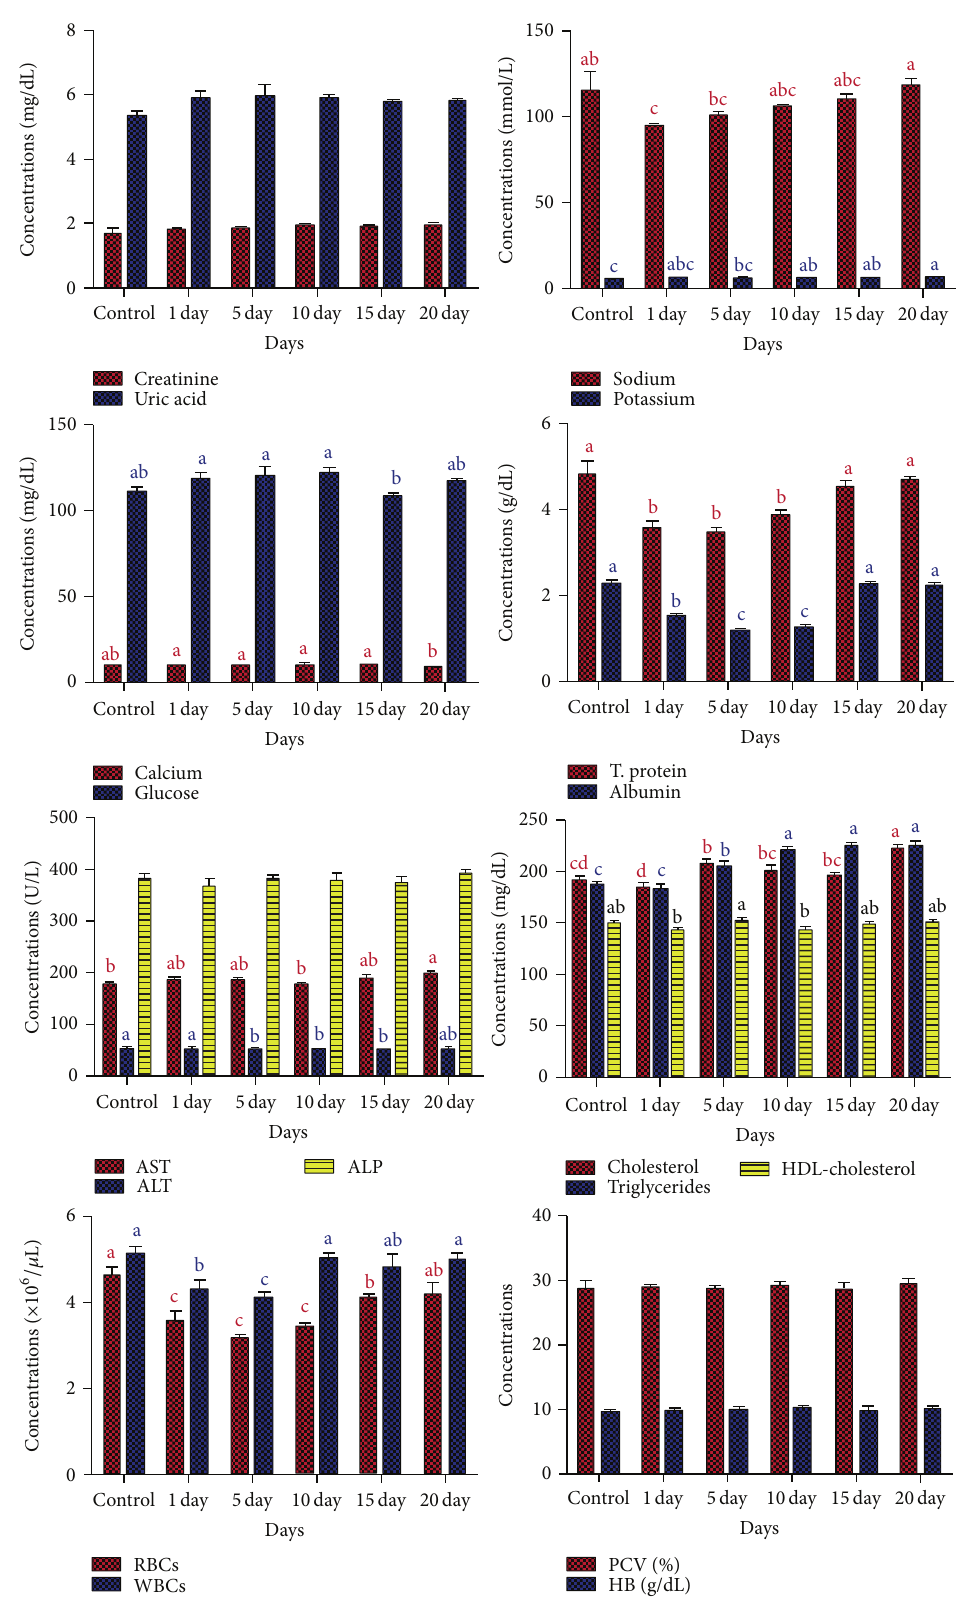
Figure 1: Effect of repeated oral administration of 25 mg/kg BW of tilmicosin daily for five consecutive days on some biochemical and hematological parameters in broiler chicken ( 𝑛 = 5